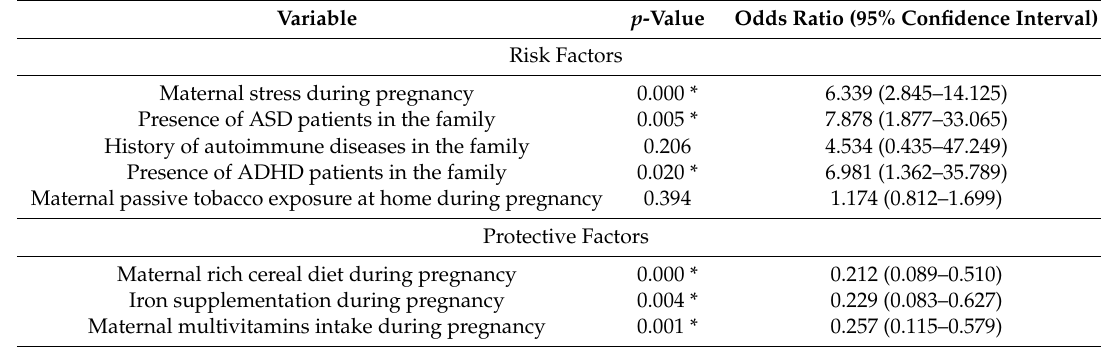
Table 4. Logistic regression analysis taking the presence / absence of ASD as dependent